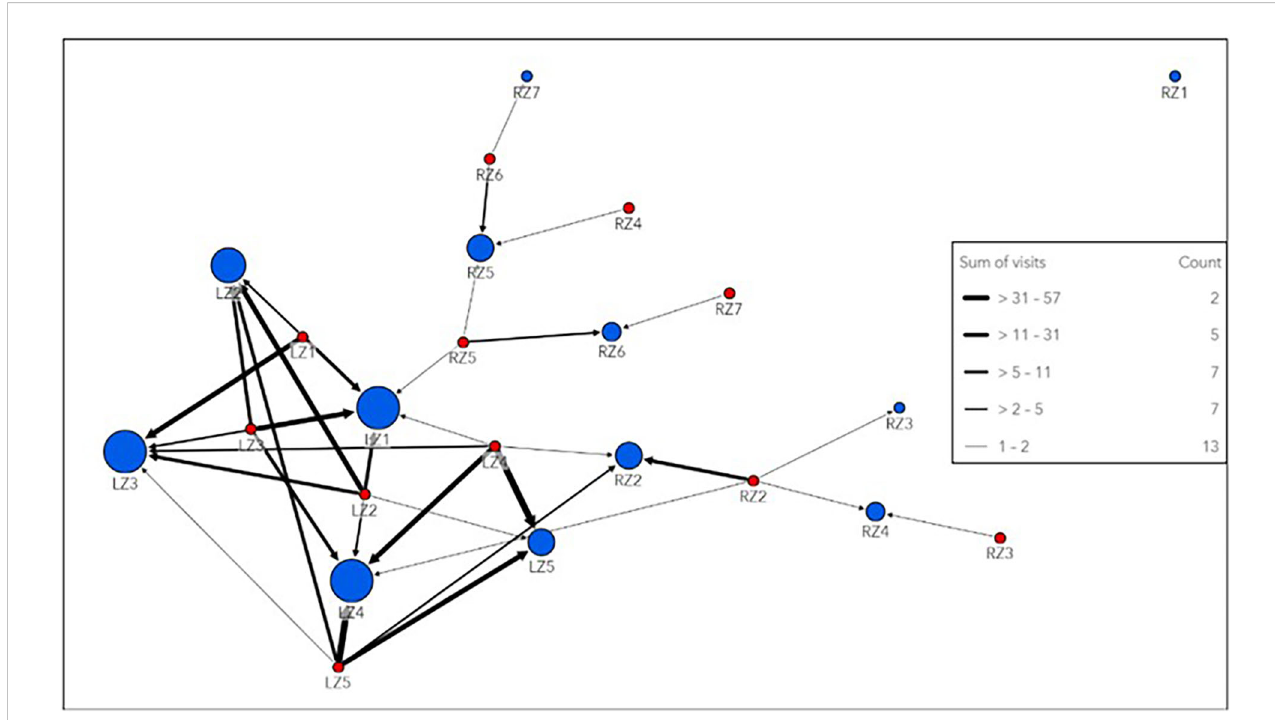
FIGURE 5 Link map of network analysis conducted on the local and regional level. This directional network has “ to ” nodes represented by blue circles and “ from ” nodes represented by red circles. Circles are sized by weighted degree, with larger circles indicating higher degree values and more connectivity with the directed network. A node may be represented more than once in the network if tagged sharks moved both “ to ” that node and “ from ” that node at some point throughout the study period. Edges are weighted by the sum of number of pathway uses of each connection between nodes and are referred to here as “ visits ” . Thicker edged lines indicate increased pathway use. This link map combines the spring/summer and autumn/winter season to visualize the movement network over the entirety of the study